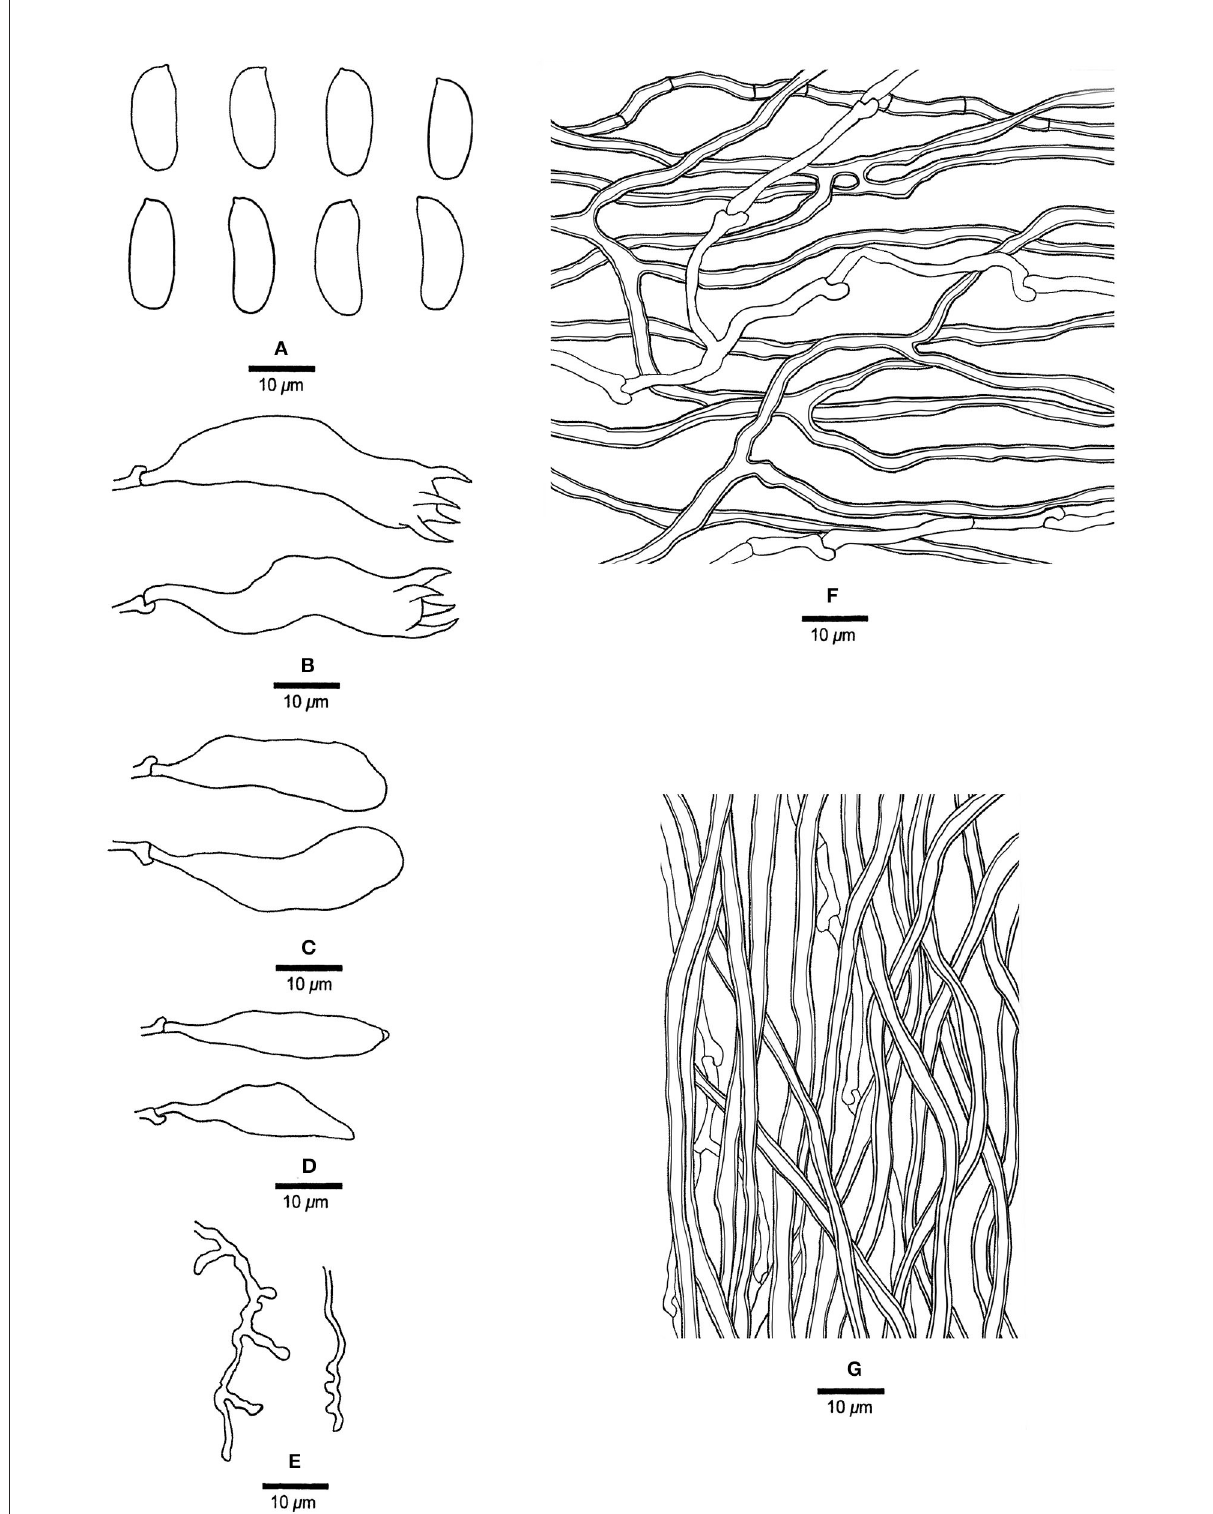
FIGURE14 Microscopic structures of Megasporia olivacea (drawn from holotype, Dai 17908). (A) Basidiospores. (B) Basidia. (C) Basidioles. (D) Cystidioles. (E) Dendrohyphidia. (F) Hyphae from subiculum. (G) Hyphae from tube